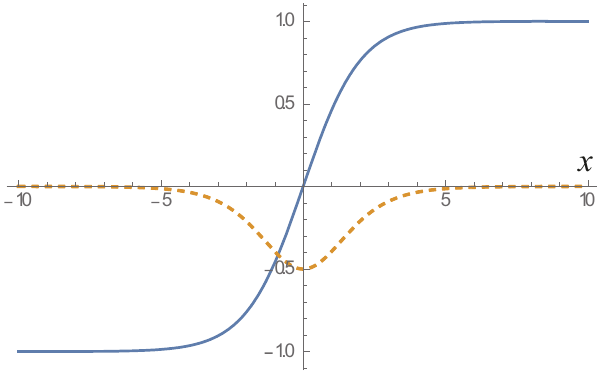
Figure 1 . The con(cid:12)guration of (cid:27) (solid line) and (cid:21) (dashed line) Here we normalize as peak of (cid:27) to be 1 and m =